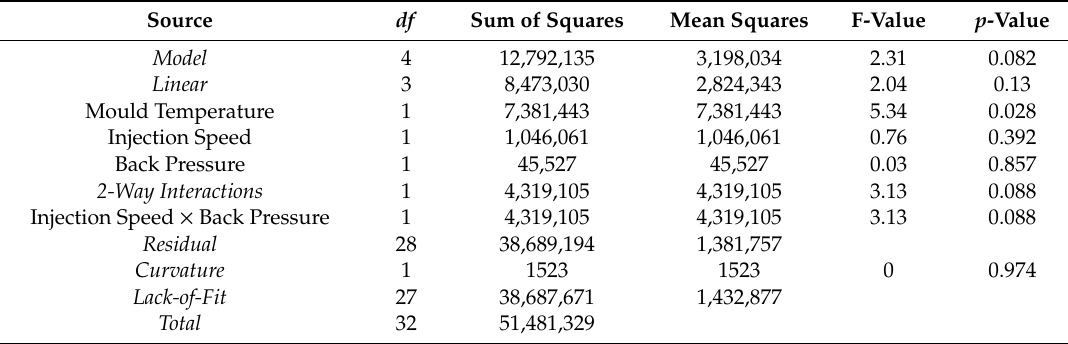
Table 5. Analysis of variance linear model for R q against processing